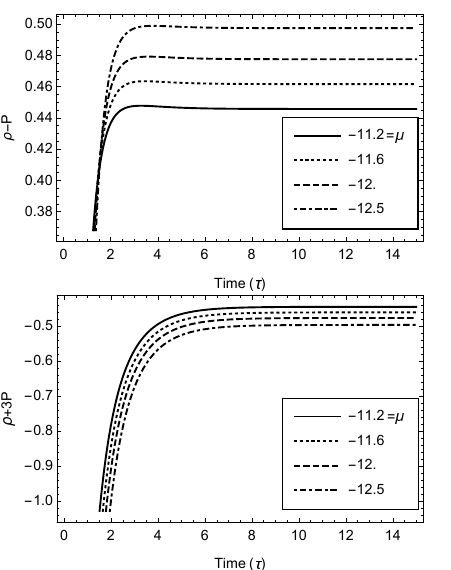
Figure 4. Variation of (a) ρ − P , (b) ρ + P , and (c) ρ + 3 P w.r.t. time (Case